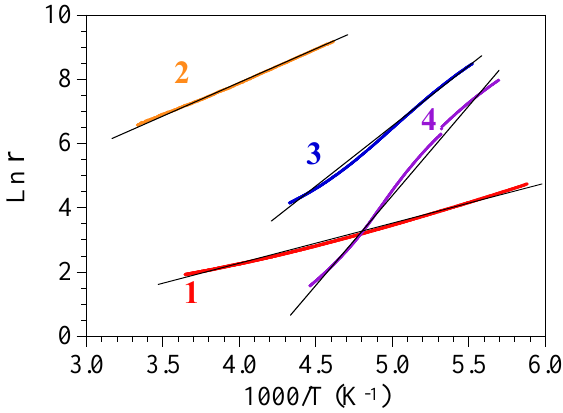
Figure 7. Arrhenius plot of the dc conductivity for compounds 1 – 4